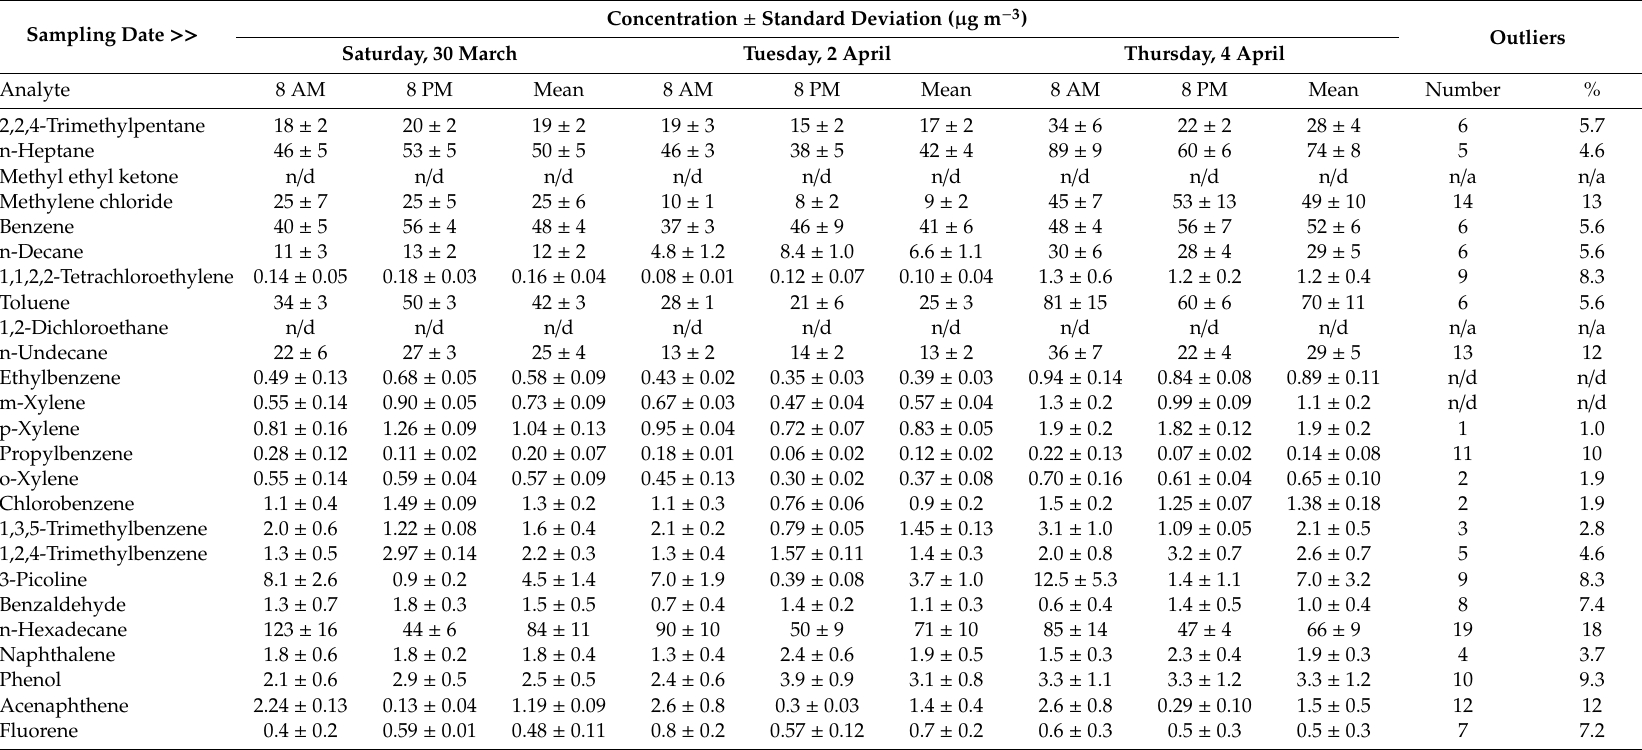
Table 6. Measured VOC concentrations in